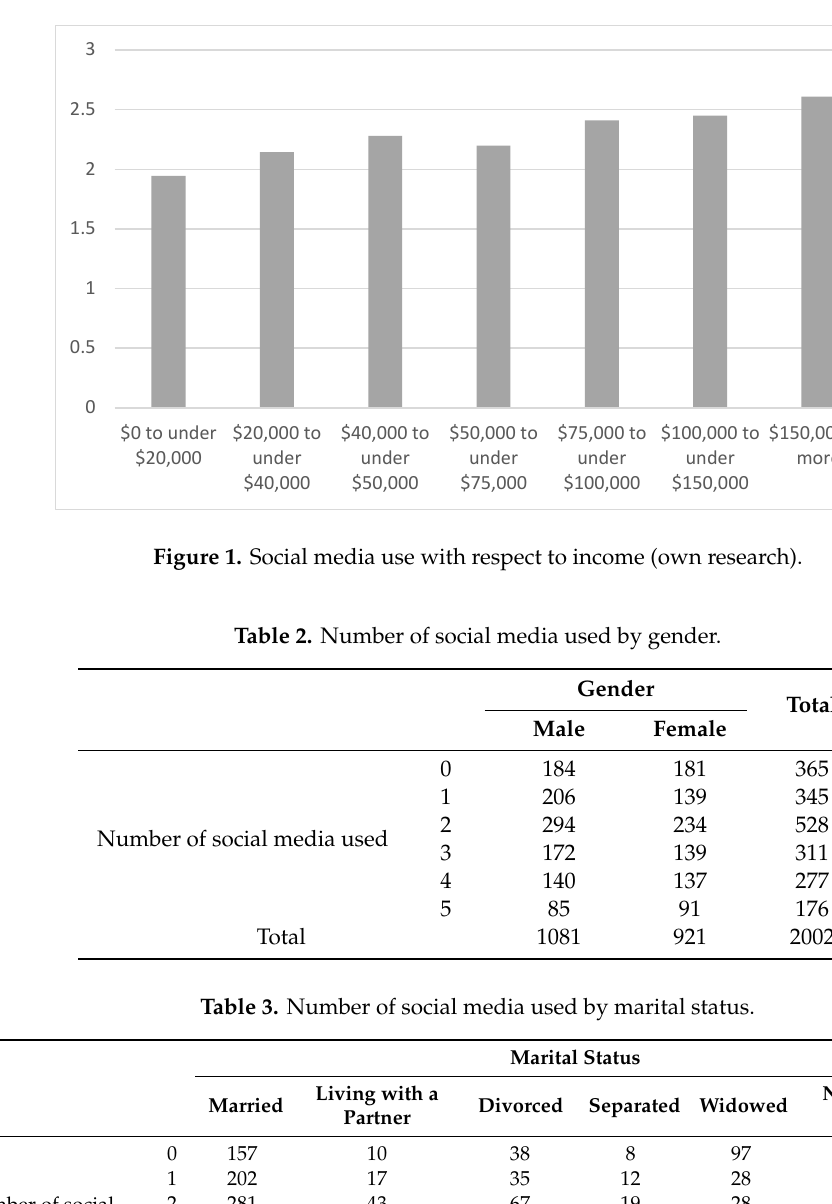
Table 3. Number of social media used by marital status.